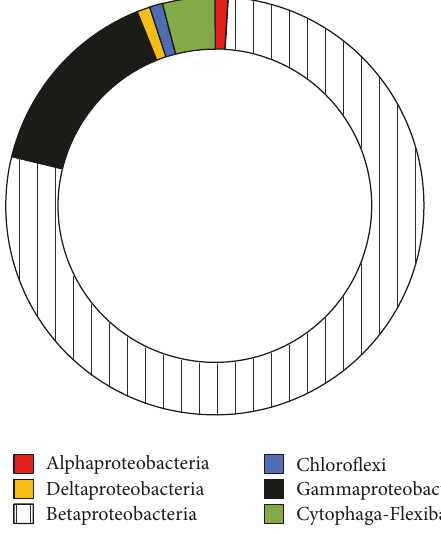
Figure 4: Pie chart of the detected taxa